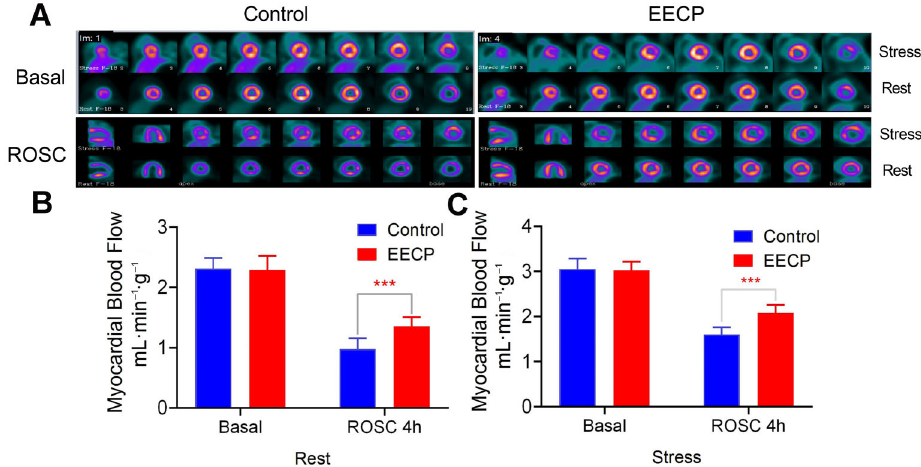
Figure 2. A , Enhanced external counterpulsation (EECP) improved the myocardial blood fl ow (MBF) after return of spontaneous circulation. The MBF of the EECP treatment group was signi fi cantly higher than that of the control group, both at rest ( B ) and under dobutamine stress condition ( C ). Data are reported as means ± SD. ***P o 0.001 ( t